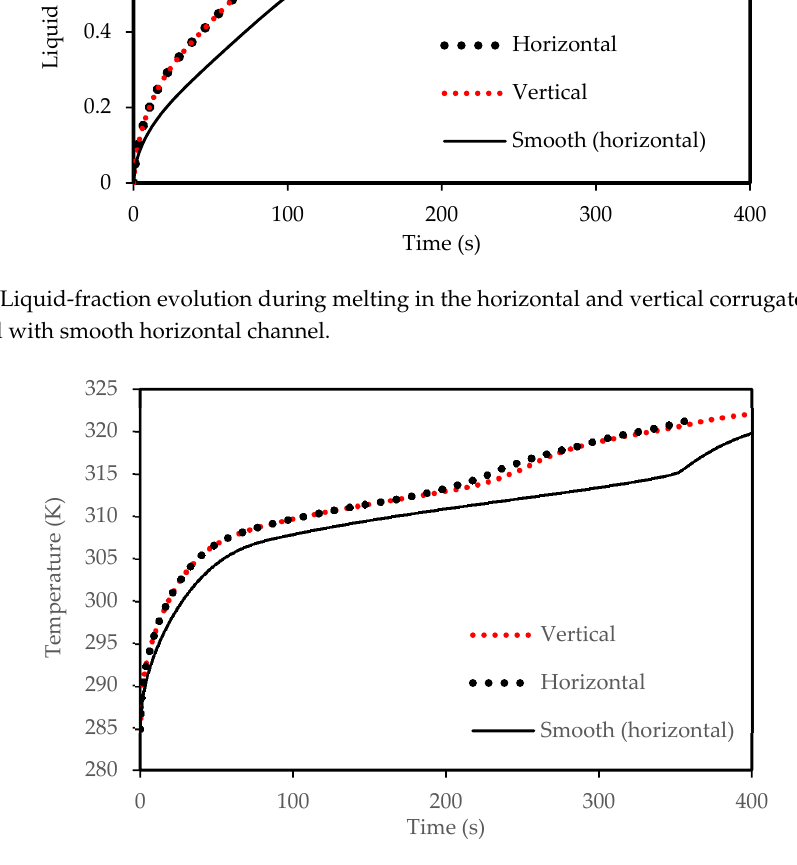
Figure 6. Temperature development in the horizontal and vertical corrugated channel compared with the smooth horizontal channel for the melting mode.